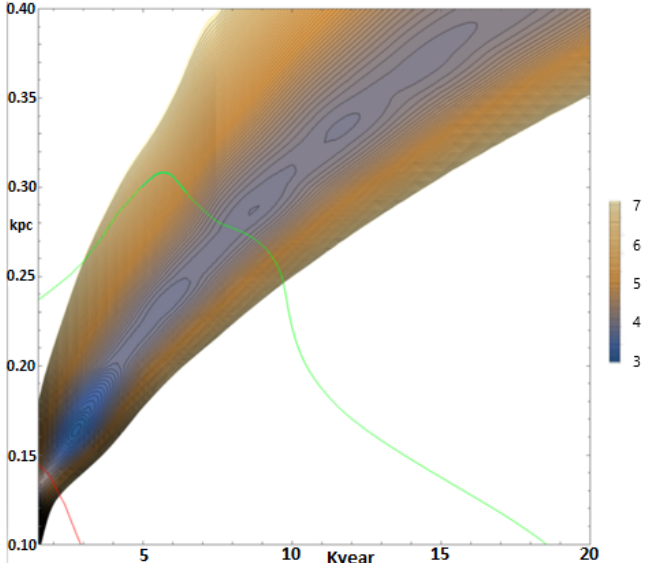
Figure 2. The map of the lines of the level of the function ξ 2 by one degree of freedom. The value ξ 2 is also transmitted in the color scale. The red line corresponds to the energy of the source 10 50 erg; the green line—energy of the source 10 51